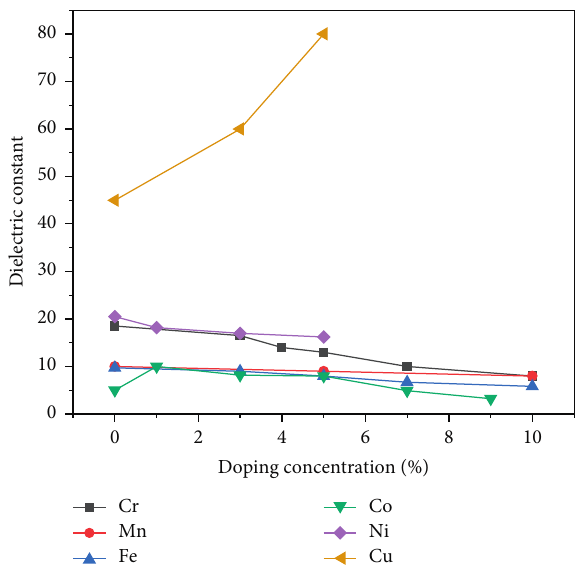
Figure 6: Variation of dielectric constant of transition metal-doped ZnO nanoparticles with respect to doping concentration at 1MHz frequency.